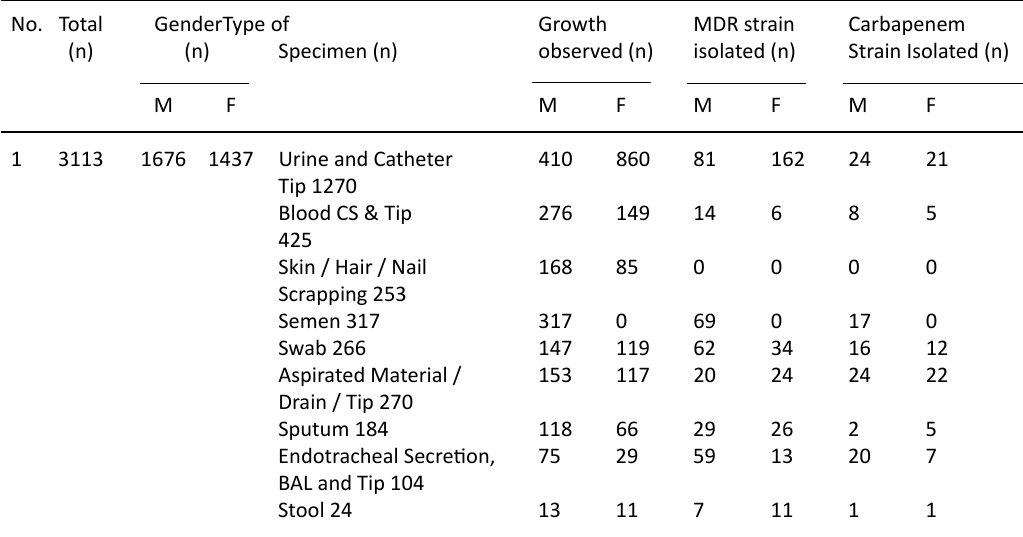
table 2. Gender wise distribution of MDR organisms No.